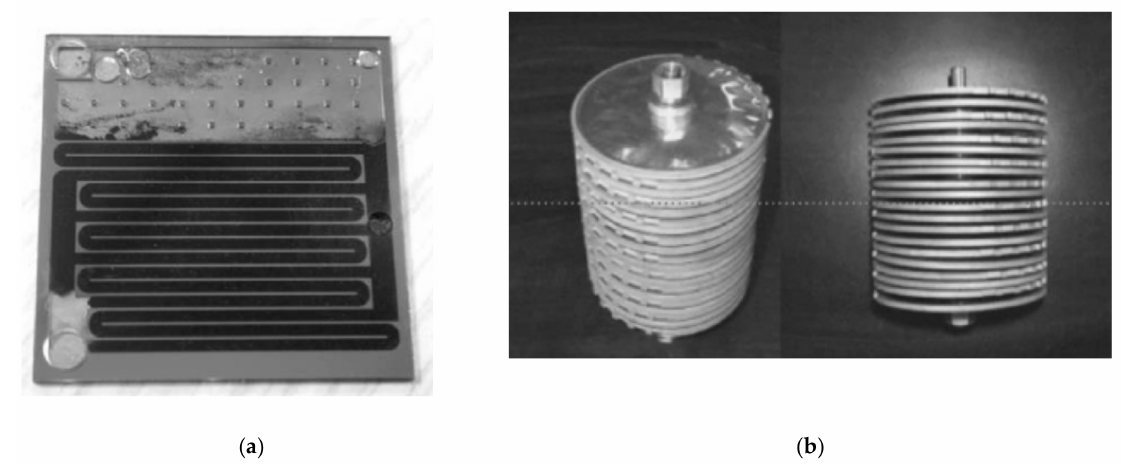
Figure 8. Hydrogen Fuel Reactors. ( a ) Catalyst packed micro-reactor [57], ( b ) Methanol reformer integrated membrane reactor